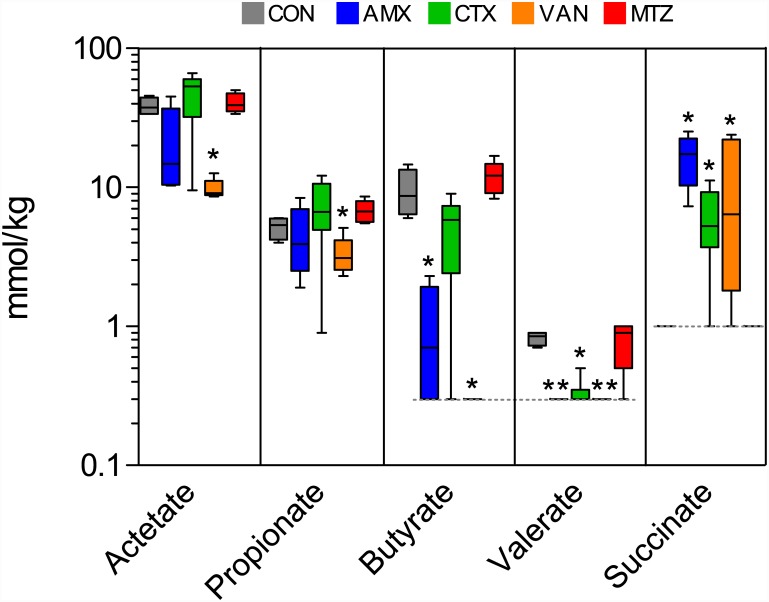
Short chain fatty acid and succinate.Concentrations of acetate, propionate, butyrate, valerate and succinate in caecum for each treatment group. Boxplots with whisker denoting the full range are shown. Control (grey), amoxicillin (blue), cefotaxime (green), vancomycin (yellow) and metronidazole (red). The dashed lines indicate limit of detection. Significant differences from CON group are indicated by asterisks (*P < 0.05, **P < 0.01).